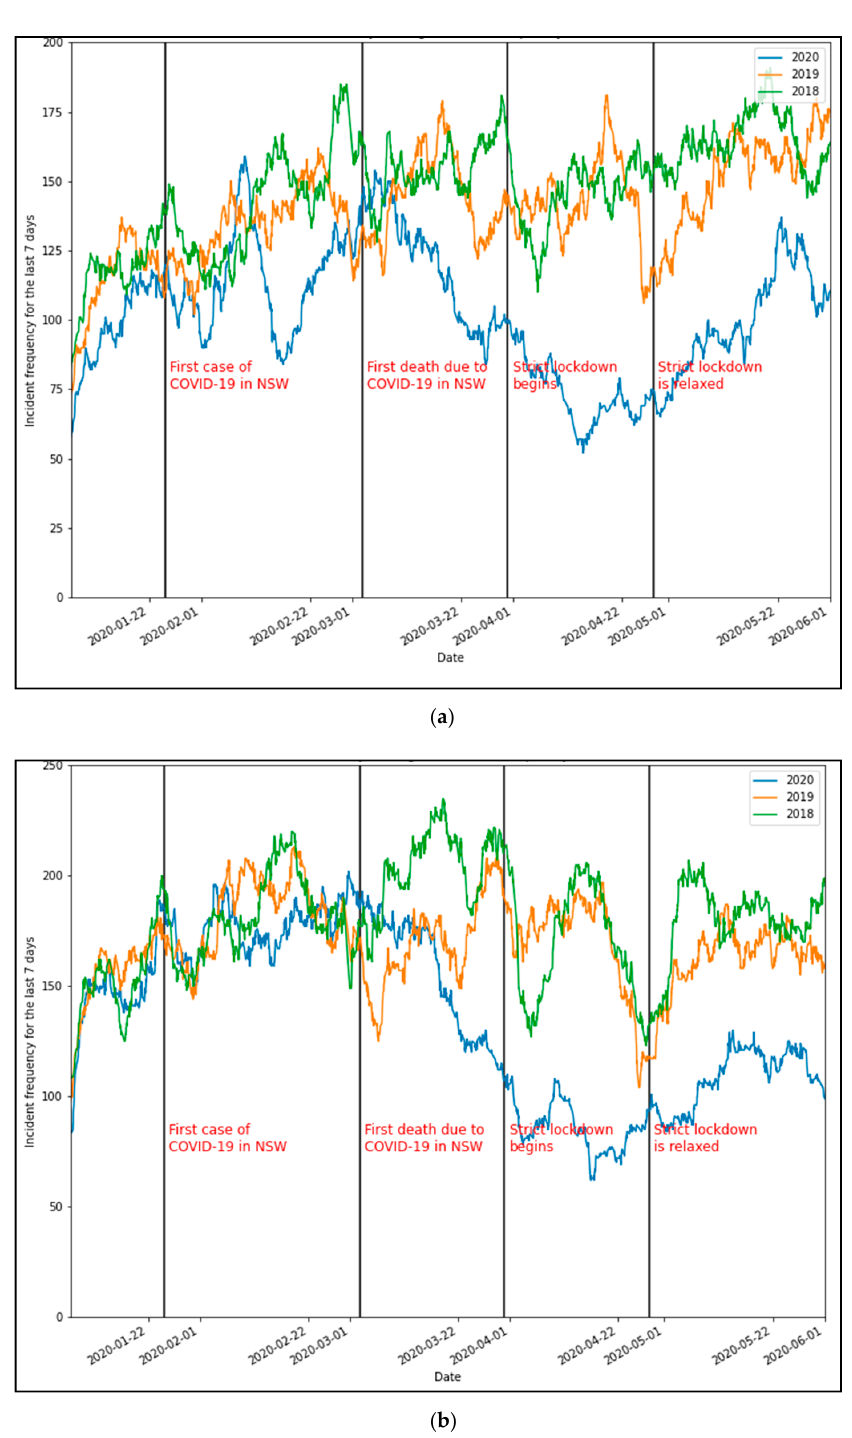
Figure 4. Comparison of seven-day rolling traffic incident frequency (2020 vs. 2018 and 2019). ( a ) Crash frequency and ( b ) breakdown frequency.